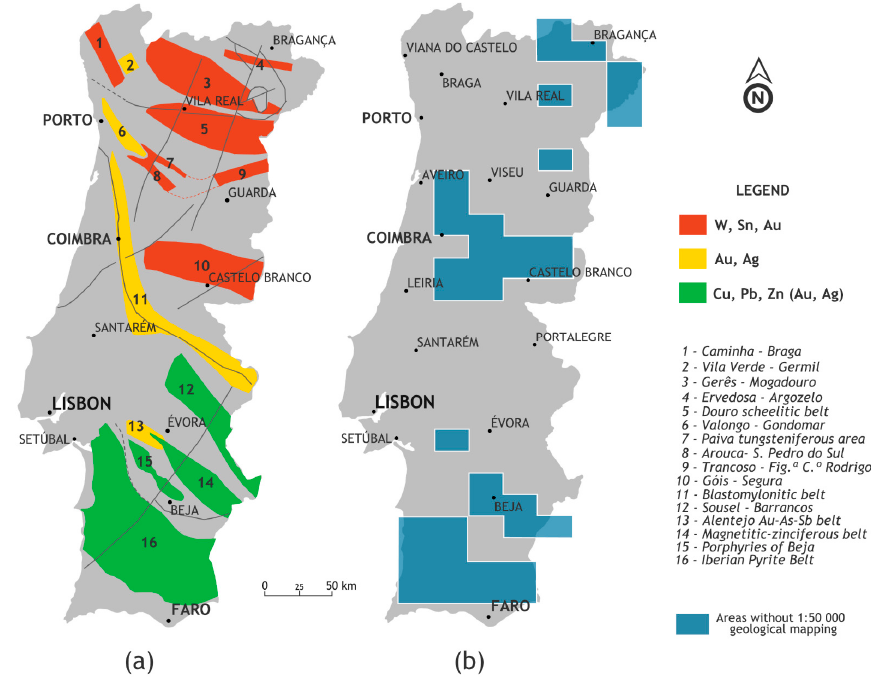
Figure 1. ( a ) Potential areas for precious and base metals in Portugal [6,7]); ( b ) areas without 1:50,000 geological mapping [7]). geological mapping